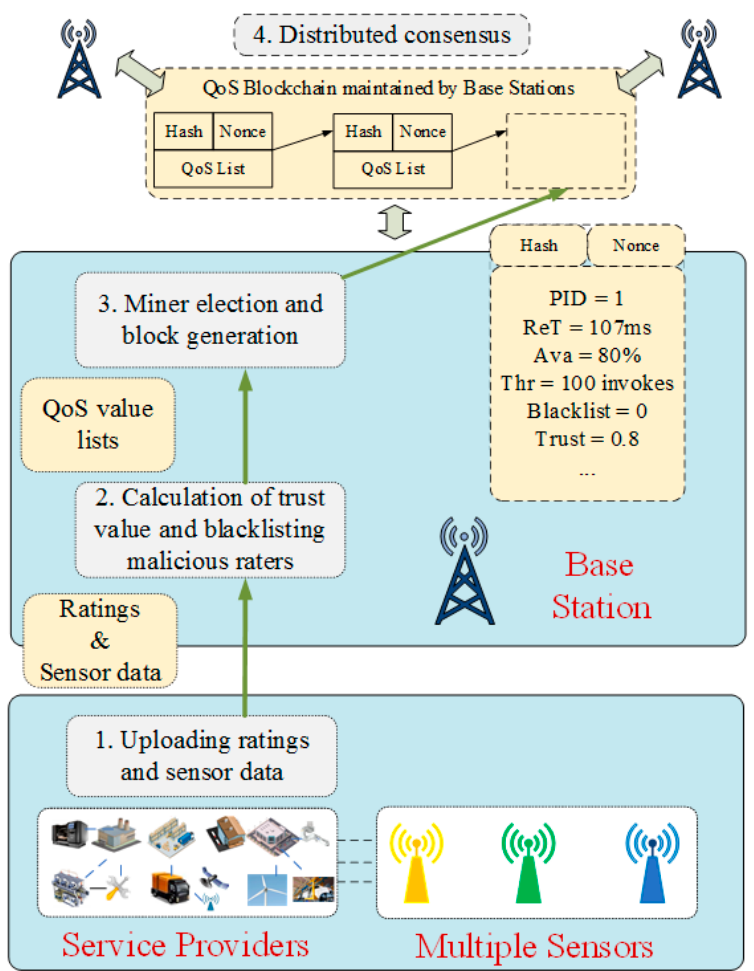
Figure 3. System design of blockchain-based adaptive trust evaluation. PID—identification number